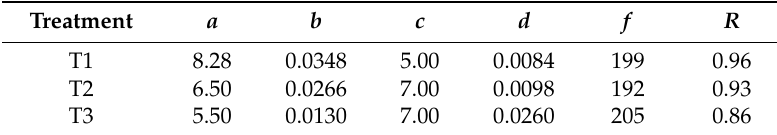
Table 4. The fitting results of the RLD distribution